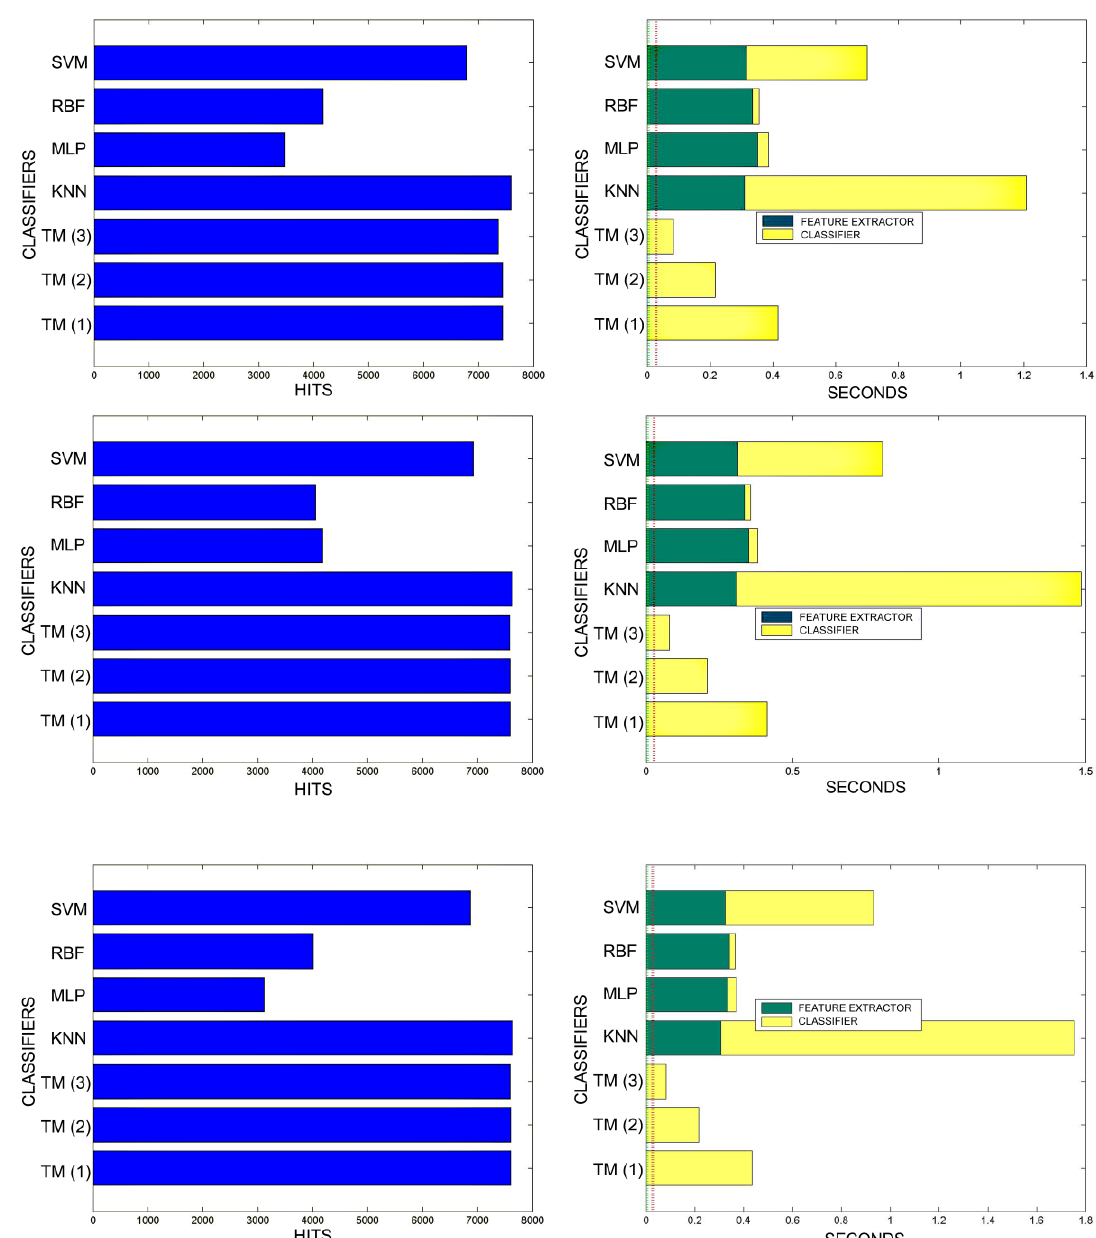
Figure 20. Comparison of successful matches on the left, in blue, and time taken for classification on the right, feature extractor in green, and classification in yellow. In descending order the training sets represent 30%, 40%, 50% of the total training samples.